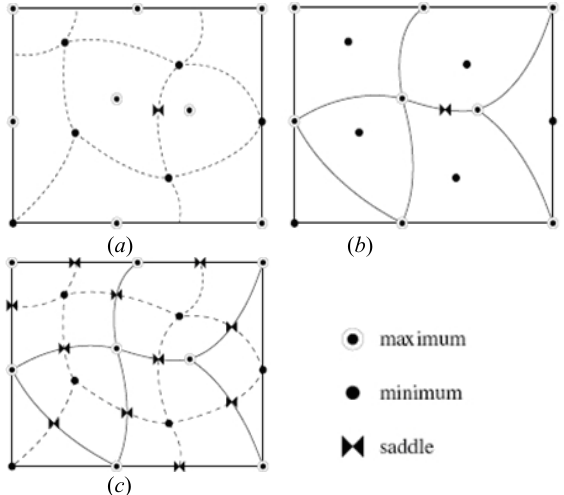
Figure 1. Morse and Morse-Smale complex: (a) Descending Morse complex, (b) Ascending Morse complex, (c) Morse-Smale complex[Danavora et al. 2007] In terrain analysis, the separatrix starting from saddle to peak is called the radge line (or radge ), while the one starting from saddle to pit is called the ravine line (or ravine ).